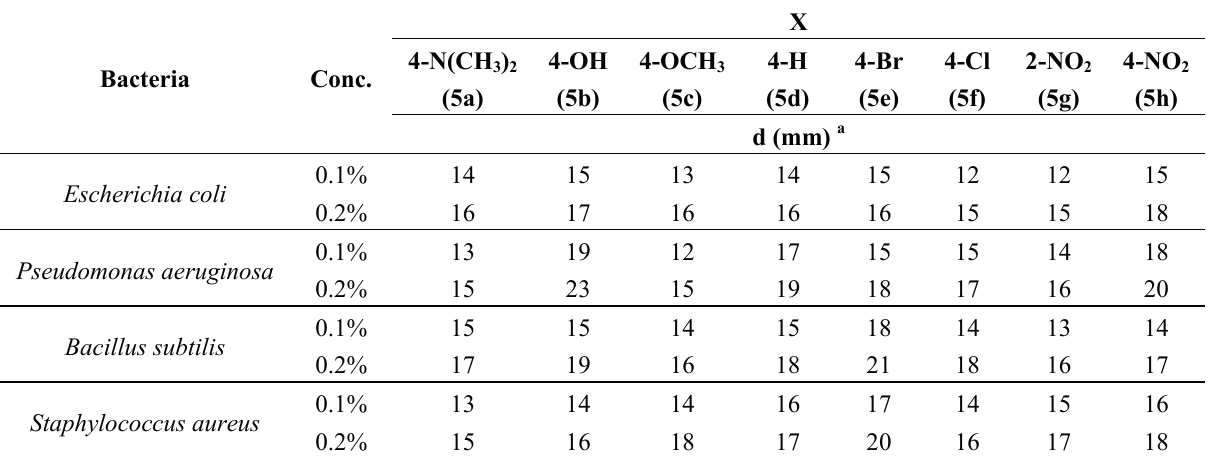
Table 1. Antimicrobial inhibition zone diameters (d) of compounds 5a – h .